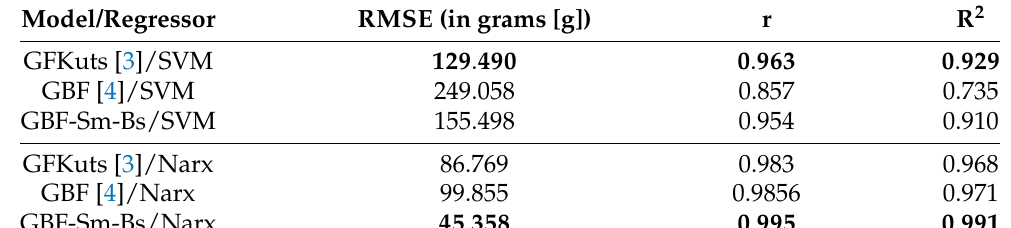
Table 2. Performance in terms of RMSE , r and R 2 for the models: GFKuts [3], GBF [4], and our proposed GBF-Sm-Bs model with both Narx and SVM regressors.